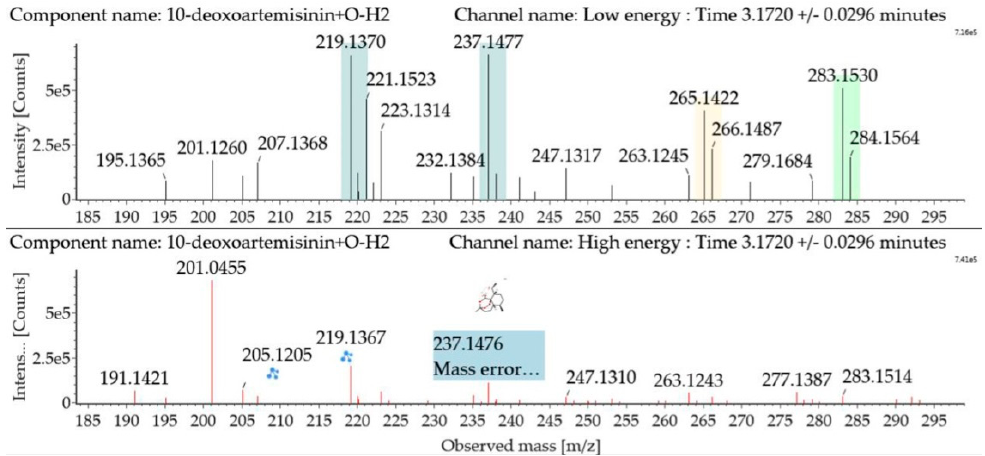
Figure 7. UPLC-ESI-Q-TOF-MS E spectra and the fragmentation diagram of hydroxylated dehydrogenated 10-deoxoartemisinin.